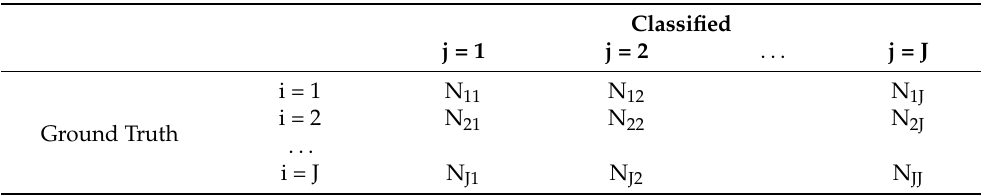
Table 4. A typical confusion